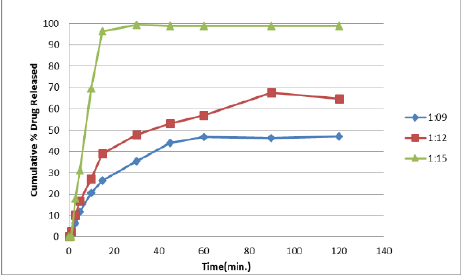
Figure 6. effect of rem: TPGS ratio